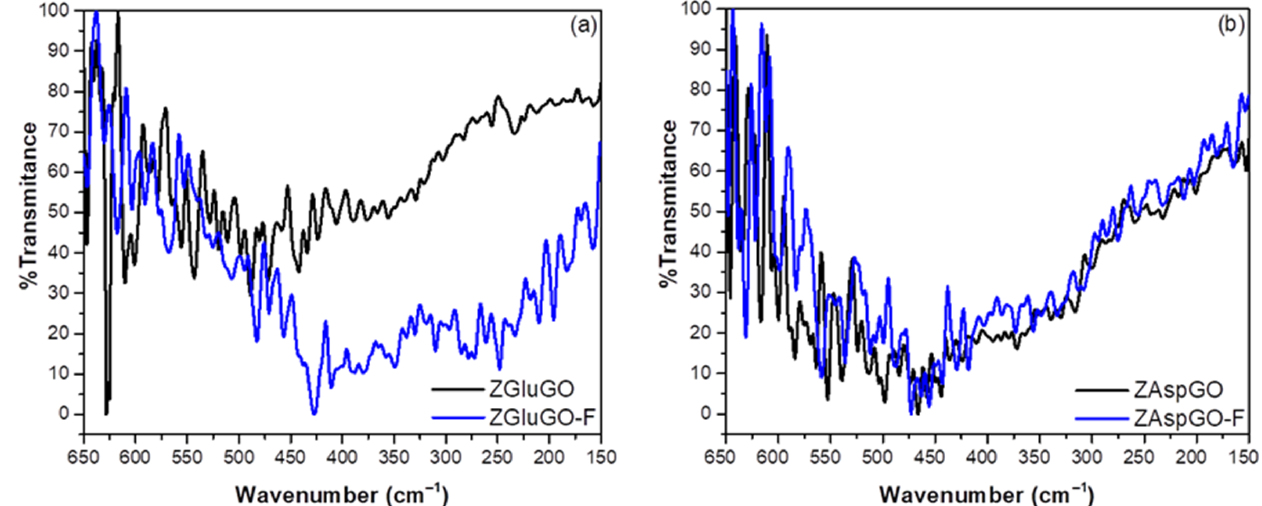
Figure 6. Far-infrared spectra of the compounds before and after fluoride ion adsorption: ( a ) ZGluGO and fluoride-treated ZGluGO (ZGluGO-F). ( b ) ZAspGO and fluoride-treated ZAspGO (ZAspGO-F).